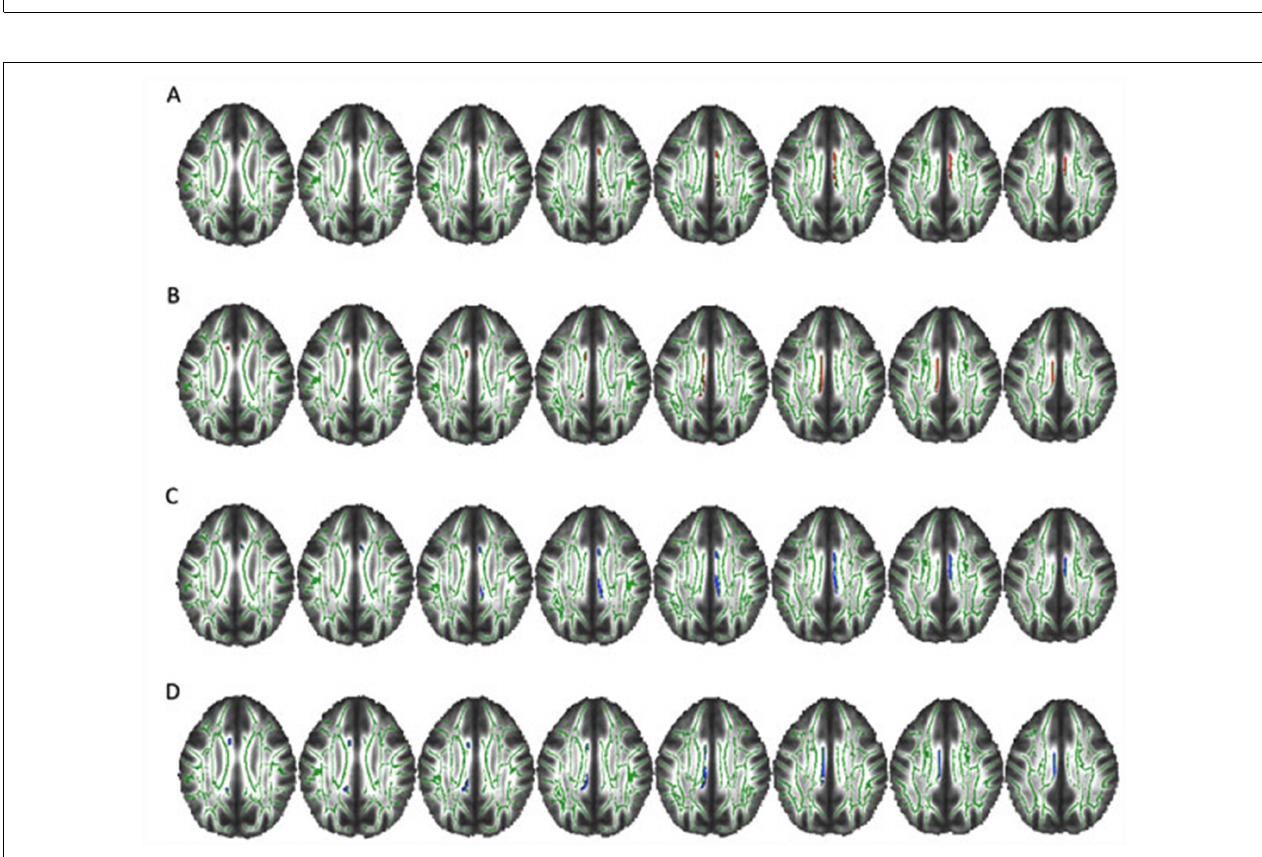
FIGURE 5 | Correlations between FA and mean diffusivity (MD) values and the duration of the illness. Axial slices. Clusters of voxels significantly different ( p < 0.05) are shown in red for FA and in blue for MD in the WM. (A,B) Negative correlation between FA value and years of disease in right ( p = 0.048) and left ( p = 0.033) CB. (C,D) Positive correlation between MD value and years of disease in right CB ( p = 0.005) and a trend in left CB ( p = 0.057).